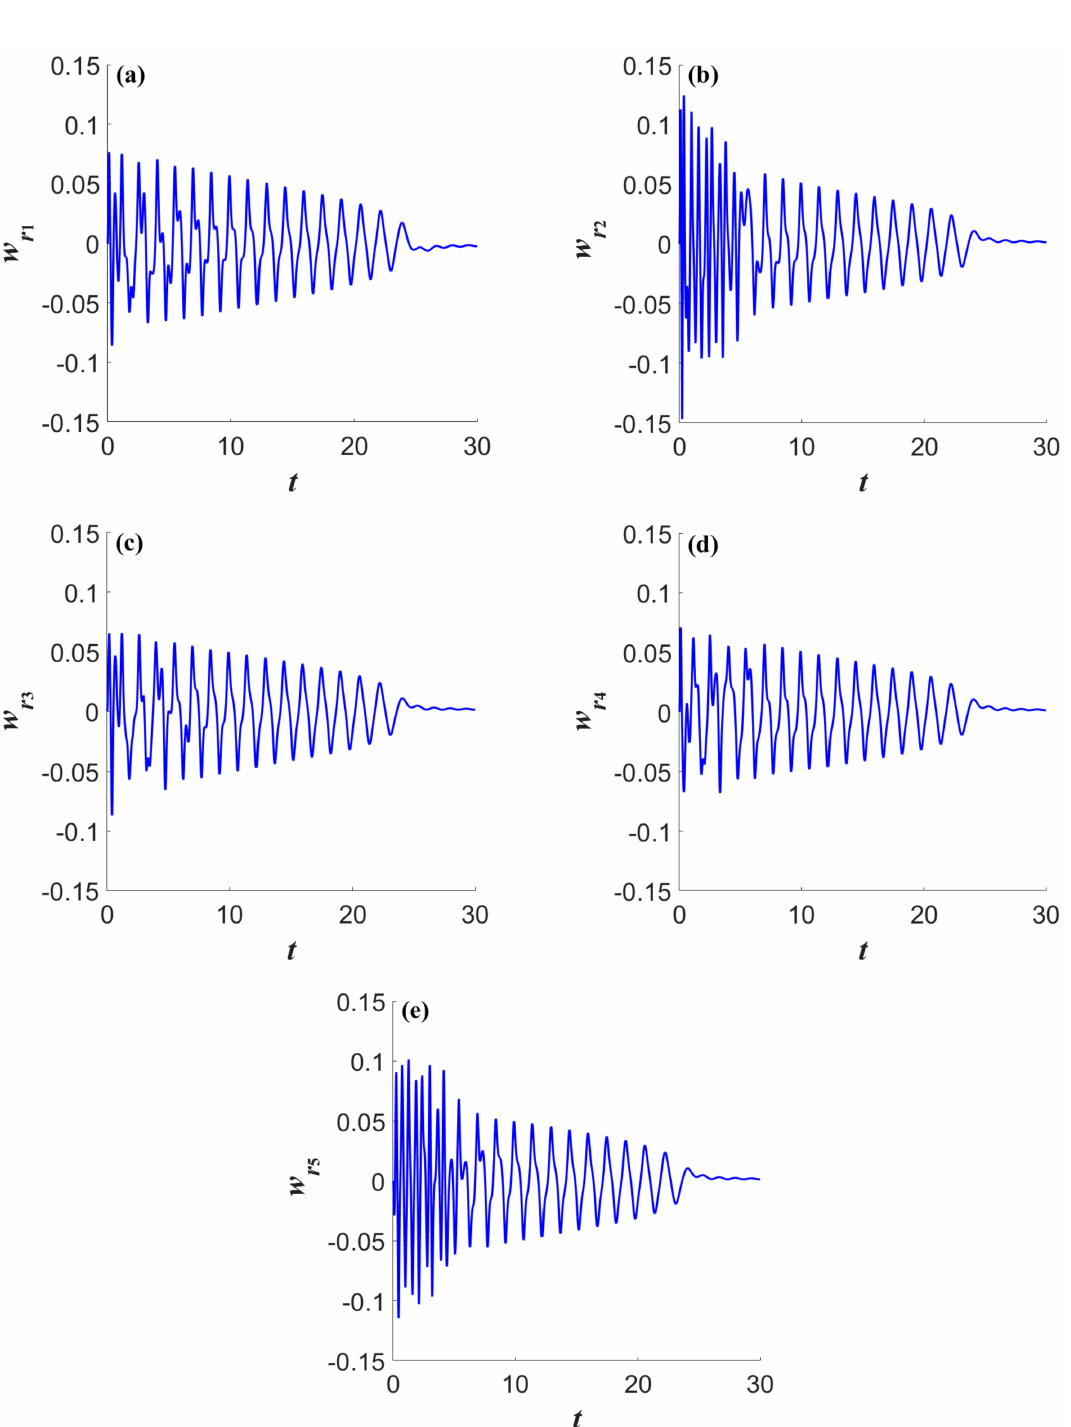
Figure 7. The relative motion between the plate and each substructure of five NESs when f = 10: ( a ) the relative motion between the plate and the N 1 ; ( b ) the relative motion between the plate and the N 2 ; ( c ) the relative motion between the plate and the N 3 ; ( d ) the relative motion between the plate and the N 4 ; and ( e ) the relative motion between the plate and the N 5